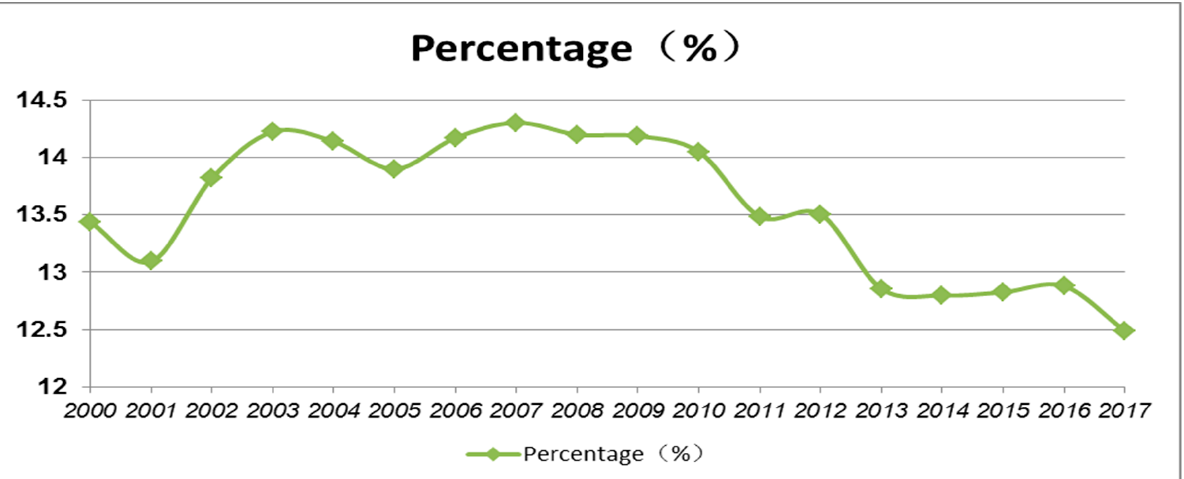
Figure 2. Carbon Emissions of Yangtze River Delta Urban Agglomerations as a Percentage of China’s Carbon Emissions, 2000–2017. Data source: Calculated based on the county’s annual carbon emissions.